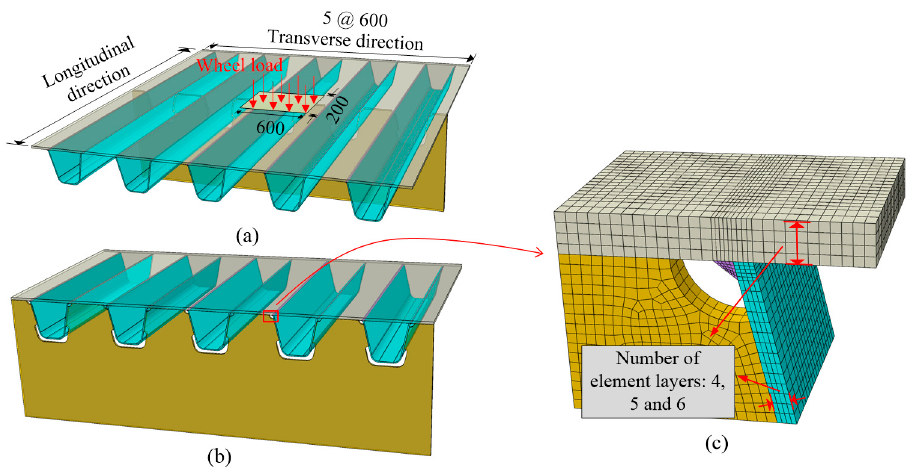
Figure 4. Schematic diagram of the local model (unit: mm): ( a ) full model; ( b ) half model; ( c ) mesh details.